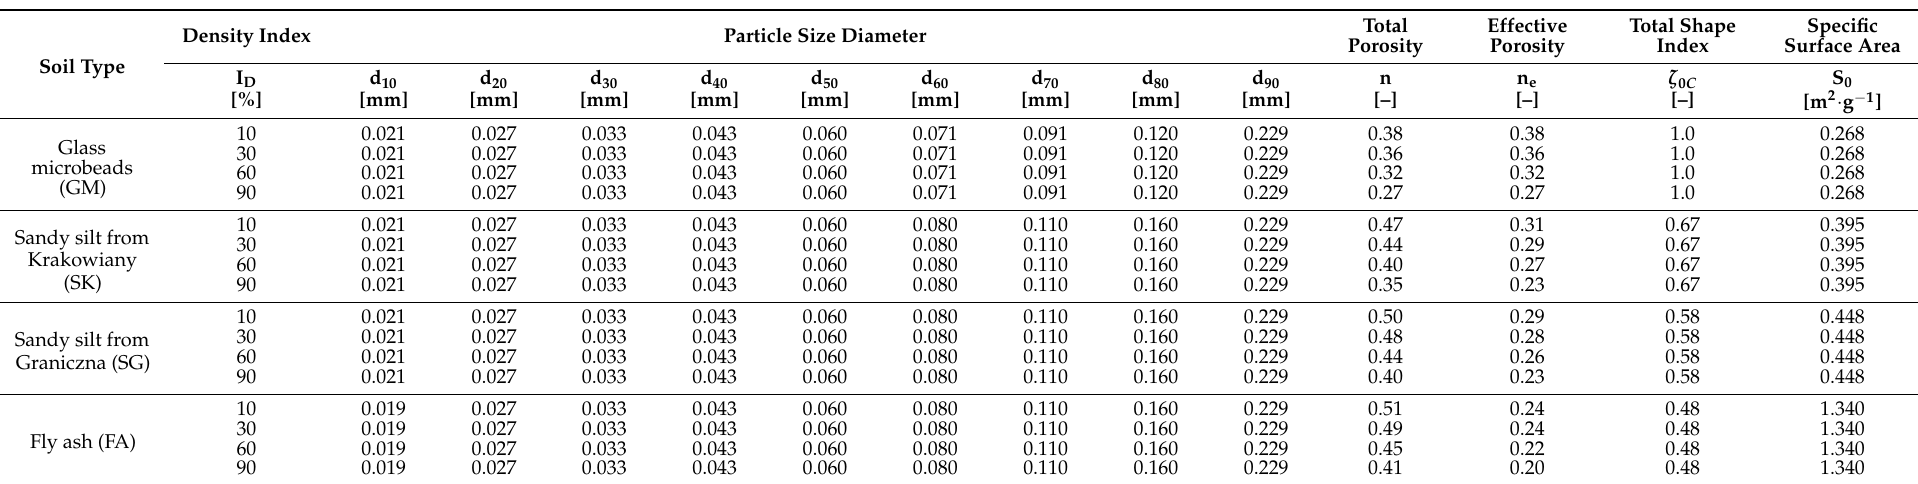
Table 1. Input parameters of